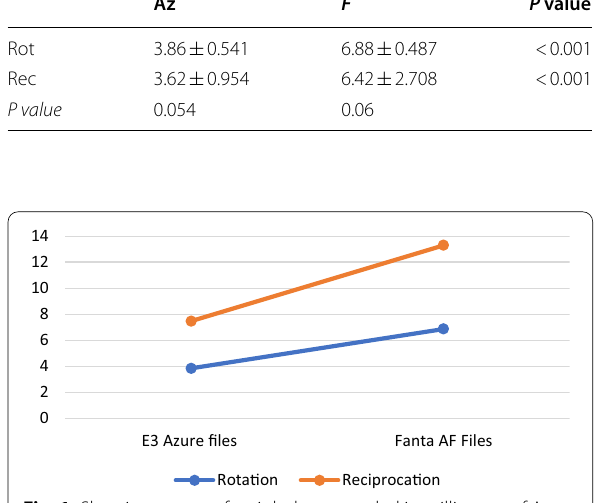
Fig. 1 Showing means of weight loss recorded in milligrams of Azure and Fanta AF One rotary systems in rotation and